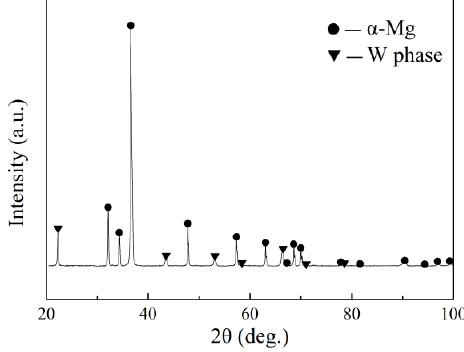
Figure 1. XRD pattern of the as-cast Mg–10Zn–6.8Gd–4Y alloy.